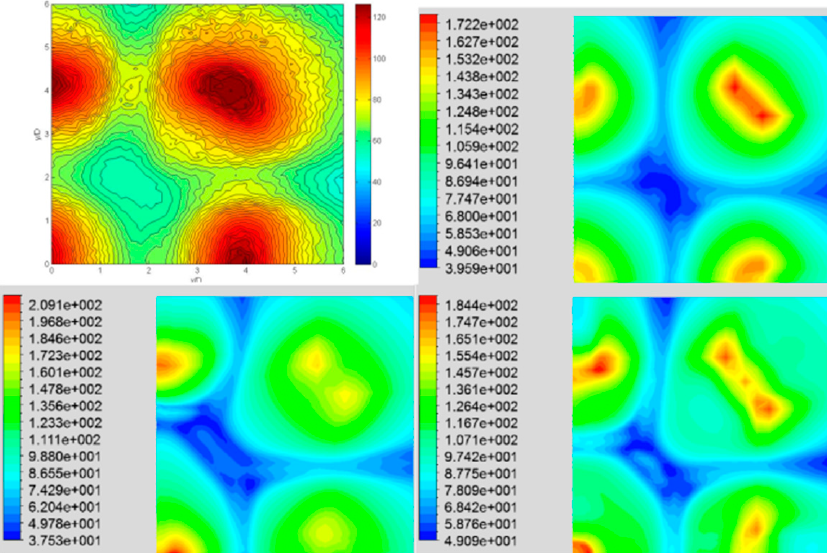
Figure 8. Nusselt contours for different turbulence models. Top left: experimental data by Geer. Top right: contours with realizable k– ε model. Bottom left: contours with k– ω SST model. Bottom right: contours with v 2 f model. The variable x / D (0-6) in the abscissa, y / D (0-6) in the ordinates. The turbulent profile from the orifice has lower values of turbulent kinetic energy on the jet axis. From a numerical point of view, this lower value of incoming kinetic energy gives a lower overestimation of k, typical of the k- ε model in stagnation